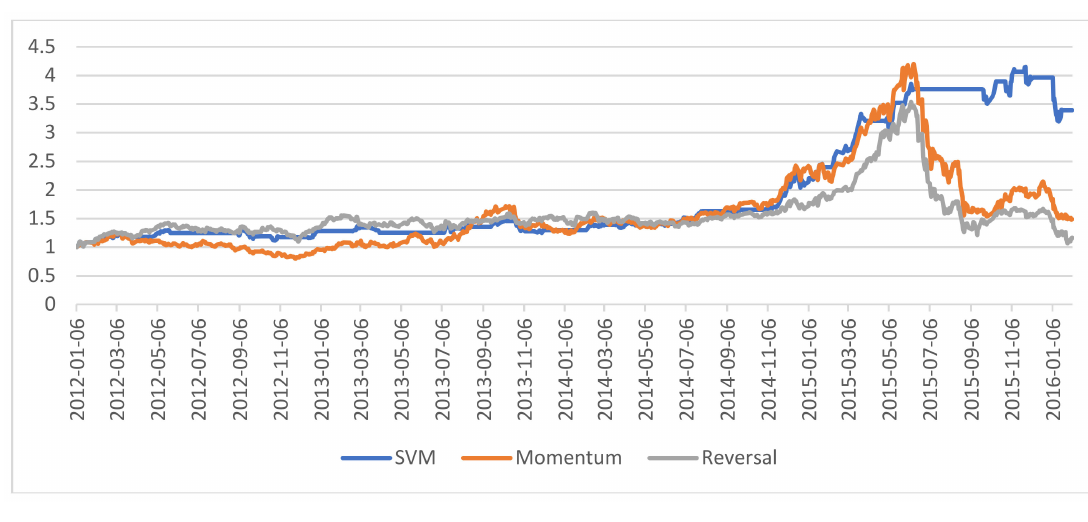
Figure 6. Portfolio performance comparison for the SVM.